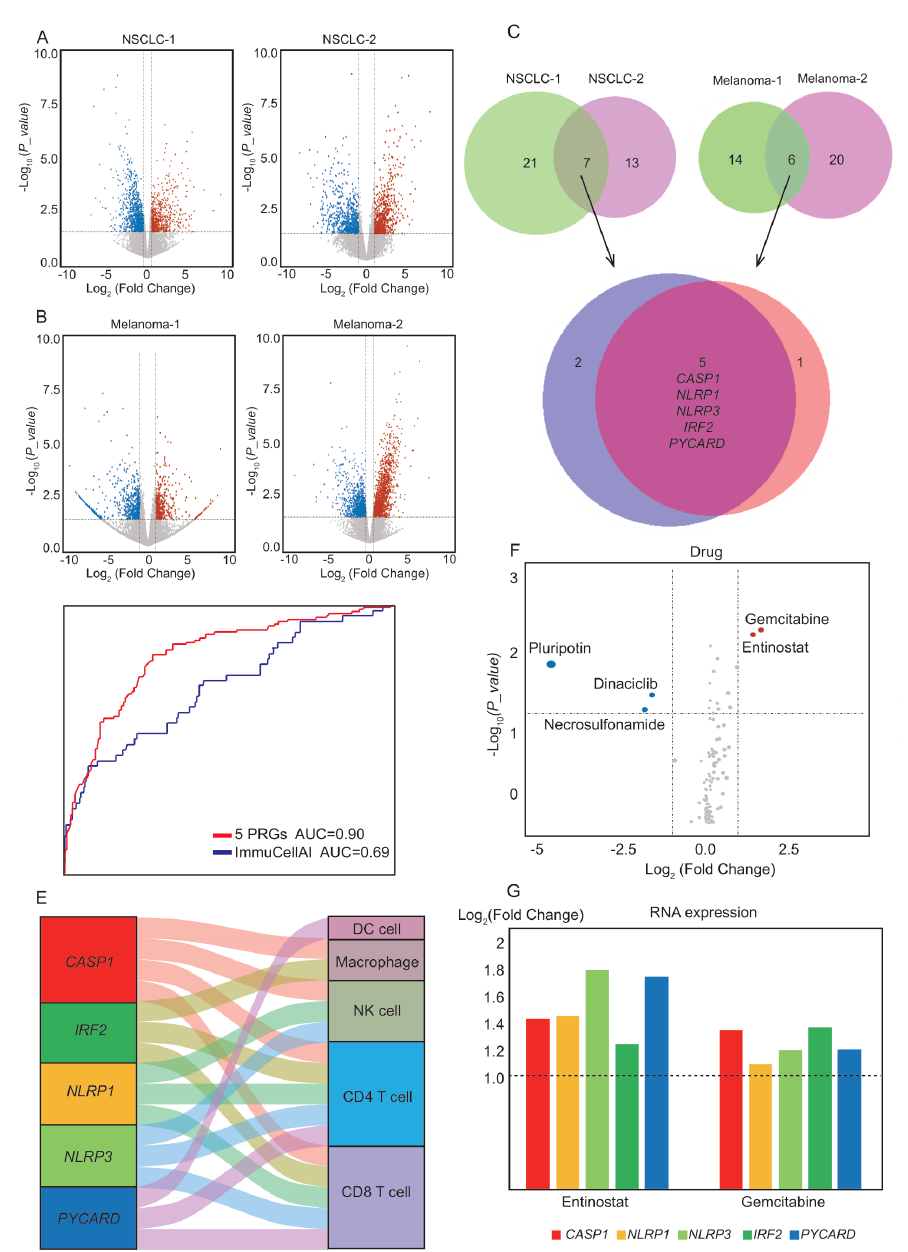
Figure 6. The effects of PRGs on immunotherapy. ( A , B ) Volcano plot of differentially expressed genes between responders and nonresponders to pembrolizumab or nivolumab in NSCLC and melanoma. The red dots in the plot represent upregulated genes, while the blue dots represent downregulated genes in responders (fold change > 1.5, P adj < 0.05). ( C ) Differentially expressed PRGs from NSCLC and melanoma. ( D ) Comparison of predictive ability of 5 PRGs and ImmuCellAI for immunotherapy population using ROC curves analysis. ( E ) Sankey diagram shows the relationship between 5 PRGs and the immune cells (DC cells, macrophage cells, NK cells, CD4+ Treg cells, and CD8+ Treg cells) in cancer patients with immunotherapy (Pearson coefficient > 0.6). ( F ) The volcano map shows the effect of different anticancer chemical drugs on the expression of 5 PRGs. The red dots in the figure represent drugs that upregulate the expression of PRGs, while the blue dots represent the drugs that downregulate the expression of PRGs. (log 2 FoldChange > 1, P adj < 0.05). ( G ) The bar plot shows changes in PRGs in response to five anticancer drugs. The crimson bar is CASP1 , the yellow bar is NLRP1 , the light green bar is NLRP3 , the green bar is IRF2 , and the blue bar is PYCARD . The vertical axis represents the multiples of the expression